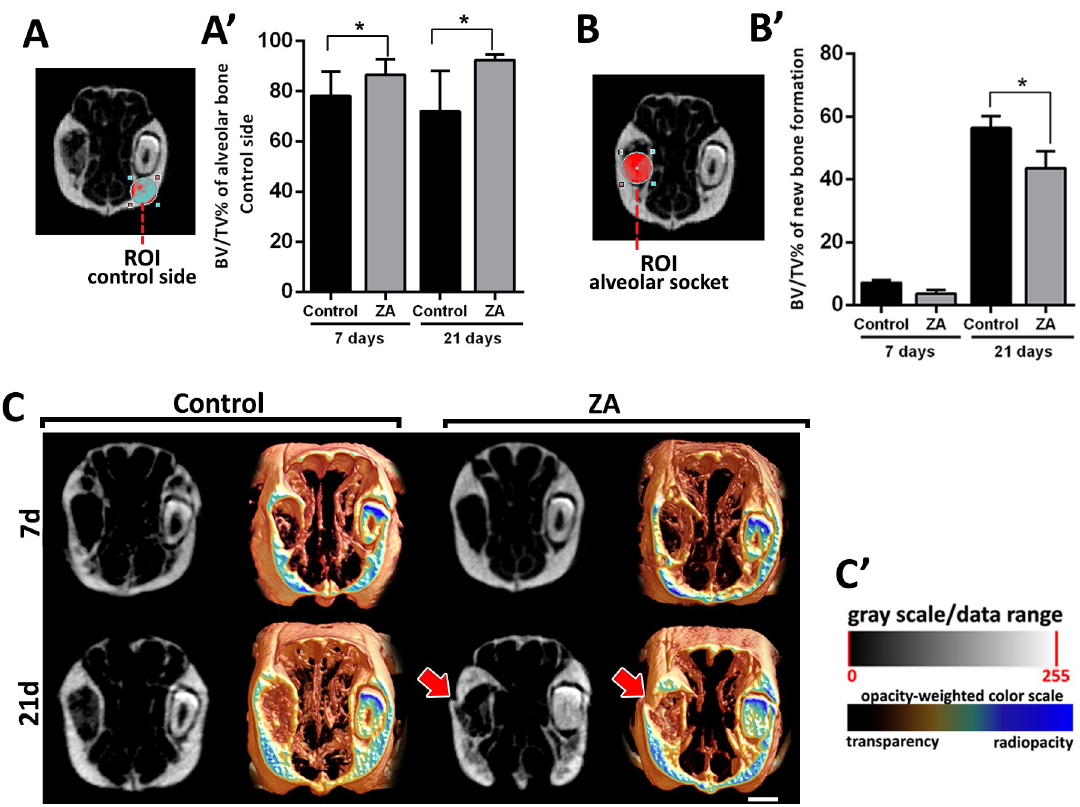
Fig 2. MicroCT evaluation of ZA cumulative effects on maxillary bone in NE sides and E sides (alveolar sockets post tooth extraction) in control and ZA treated mice. Senescent 129 Sv-WT female received IP injections of 0.9% saline solution (Vehicle) or 250 μ g/Kg once a week, and upper right incisor were removed at 4 week of each treatment. Mice were euthanized for maxillary bones removal after 7days and 21days post tooth extraction. A) BV/TV (%) of intact bone (NE side) and B) in the alveolar socket post tooth extraction (E side). C)Three-dimensional representative images obtained with the CT-Vox software (Skyscan, Kontich, Belgium), showing transverse sections of Control and ZA maxillary bones at 7days and 21days post tooth extraction. A bone fracture is observed in ZA treated mouse at 21 days post tooth extraction (red arrow). Results are presented as the means ( ± SD) of each parameter. Symbol � indicates a statistically significant difference vs control (p <